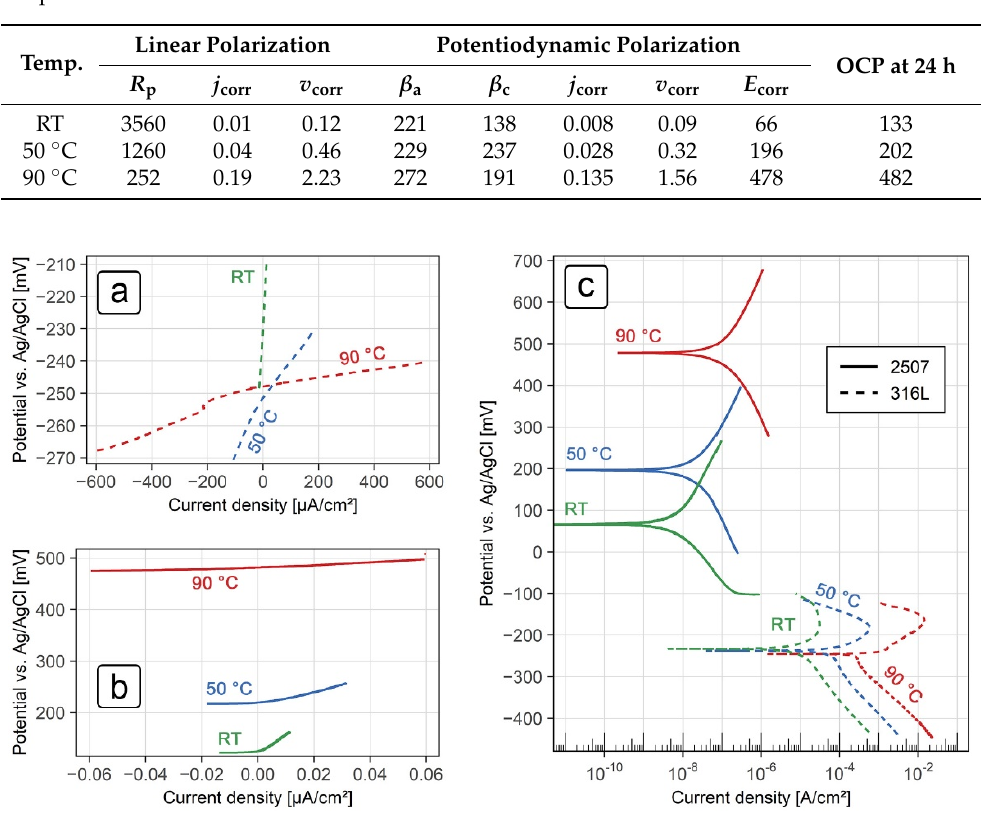
Figure 6. ( a ) Linear polarization curves for the grade 2507 stainless steel in a 10% H 2 SO 4 solution with 5000 mg/L NaCl at various temperatures; ( b ) linear polarization curves for the grade 316L stainless steel in a 10% H 2 SO 4 solution with 5000 mg/L NaCl at various temperatures; ( c ) potentiodynamic polarization curves for both grades of stainless steel in a 10% H 2 SO 4 solution with 5000 mg/L NaCl at various temperatures.